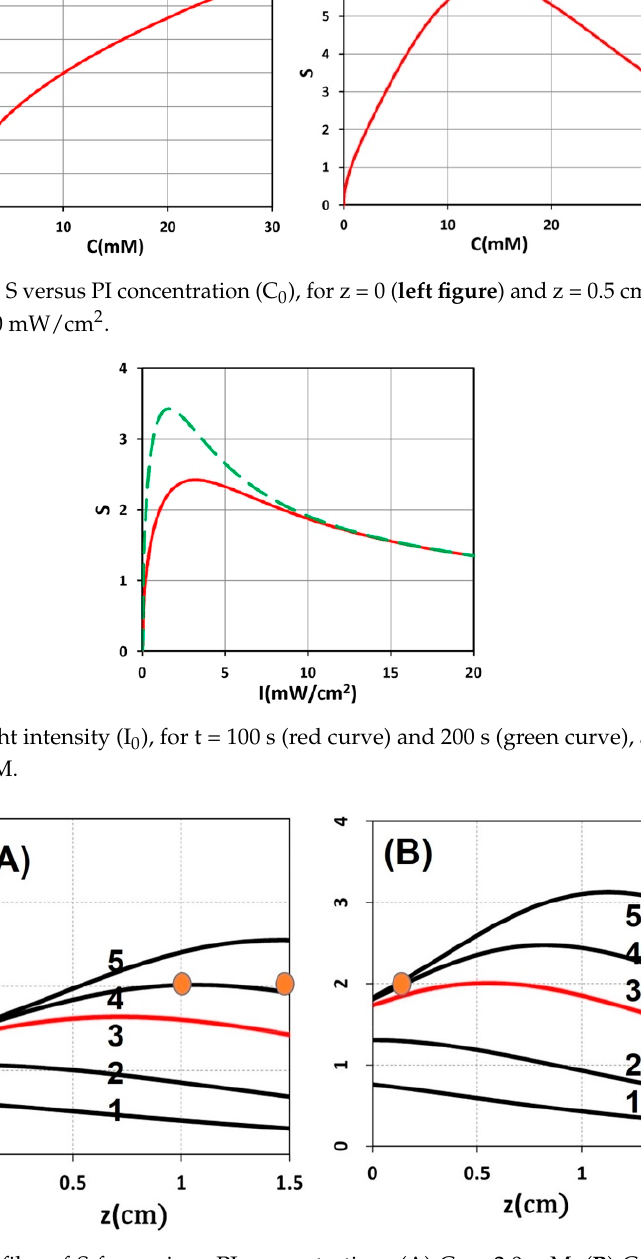
Figure 8. Spatial profiles of S for various PI concentration: ( A ) C 0 = 2.0 mM, ( B ) C 0 = 3.0 mM, at exposure time t = (30, 70, 165, 250, 400) s, with a’= 0.6, b’ = 0.1 (1/mM/cm), Q = 0.5 (1/cm), and I 0 = 10 mW/cm 2 , using the analytic formula of Equation (5) with fit m = 0.001.